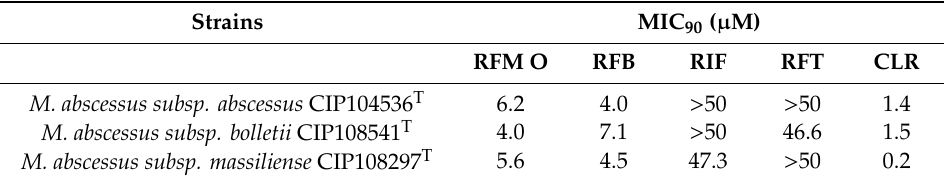
Table 1. Ninety percent minimum inhibitory concentration (MIC 90 ) of rifamycin O against reference subspecies of the M. abscessus complex in comparison with reference compounds in 7H9 G/T/ADC .